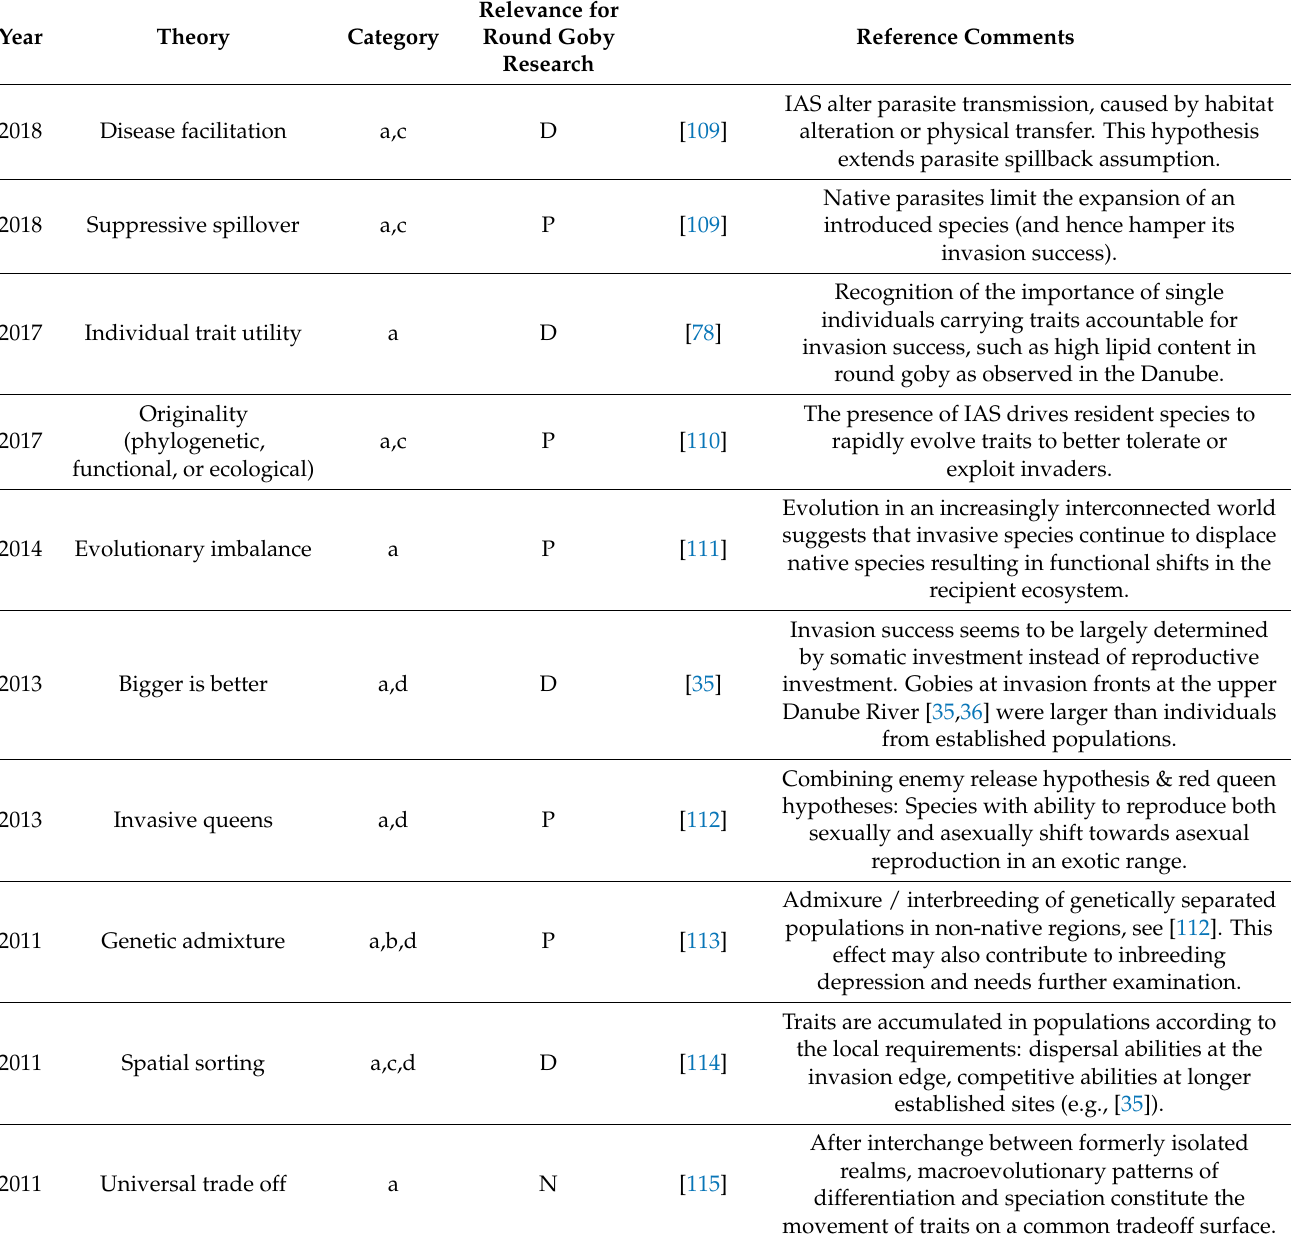
Table 2. Selection of important hypotheses in invasion biology compiled from multiple literature sources with their relevance to round goby research (D = documented, P = potentially relevant, N = not relevant). The theories were sorted by the year of publication and were assigned into functional categories: (a) invasion theory, (b) pathways and vectors, (c) community